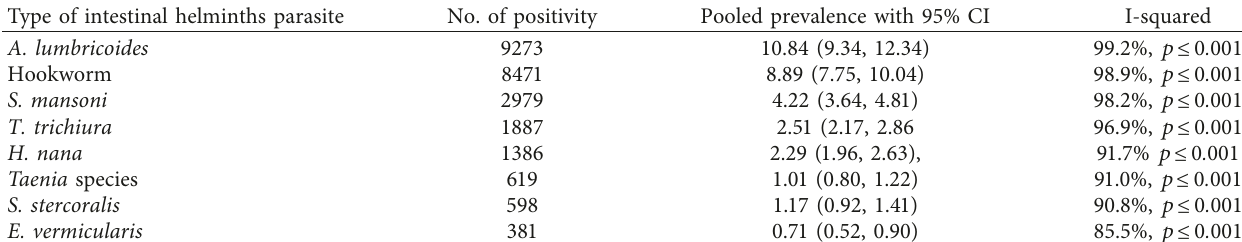
Table 3: Pooled prevalence of some common intestinal helminth parasites among people in